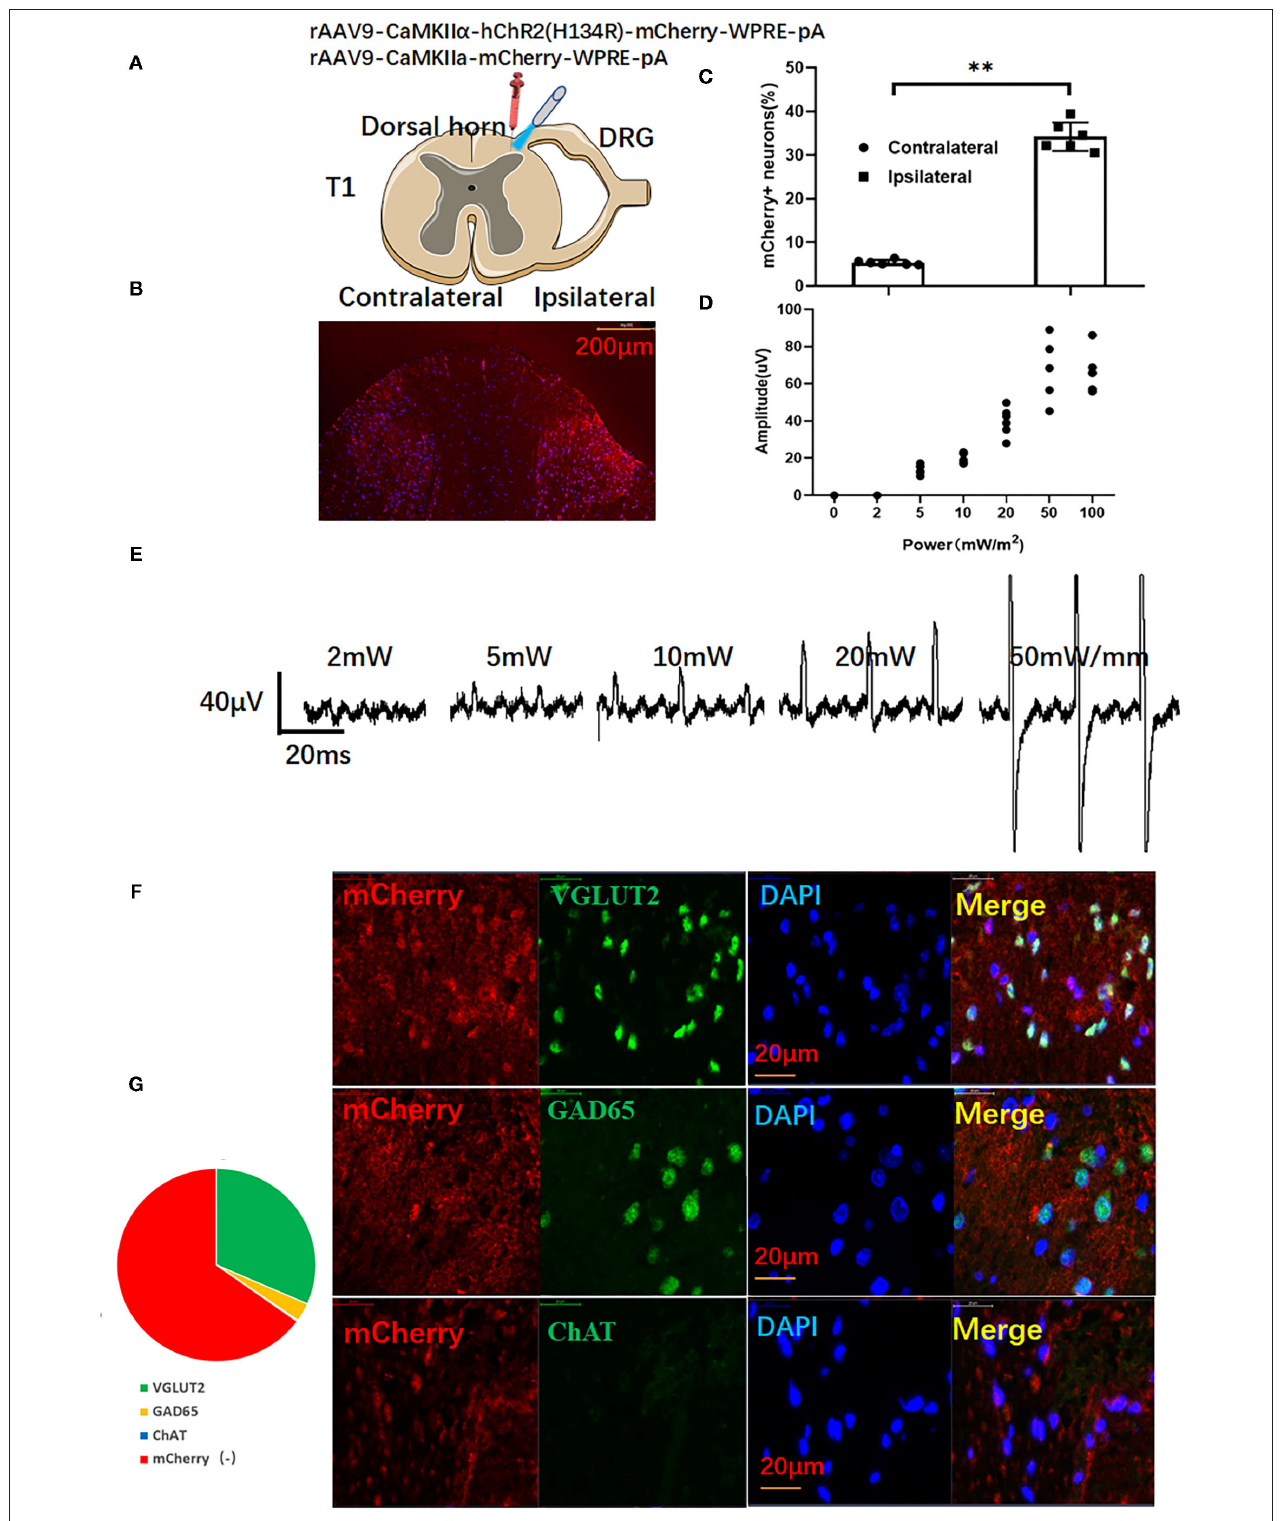
FIGURE 1 | The activation of ChR2-expressing glutamatergic neurons in the dorsal horn induces myoelectric potentials of the left upper limb. (A) Adeno-associated virus (AAV)-carrying ChR2 or empty vector-transfected left dorsal horn (red syringe) for optical stimulation by a blue laser (473nm). (B) Representative images of mCherry in the dorsal horn. (C) Viral transfection efficiency. (D) The optical stimulation of dorsal horn neurons induces electromyography (EMG) of the left upper limb